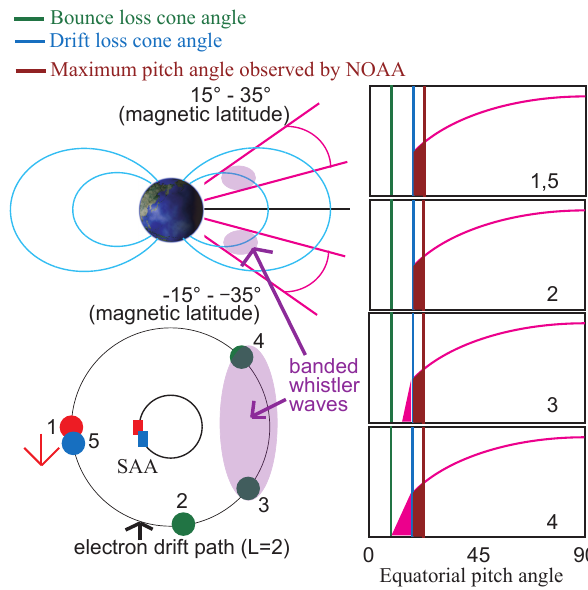
Fig. 8. Schematic illustration of method of numerical calculation. The middle and bottom panels on the left indicate the region of the banded whistler mode waves and an electron trajectory along the one drift path at L =2.0, respectively. The right panels show schematic pitch angle distributions corresponding to the numbers in the bottom panel on the left. The solid green, blue, and brown lines exhibit the bounce loss cone angle, drift loss cone angle, and the maximum pitch angle observed by the NOAA 12 satellite, respec-